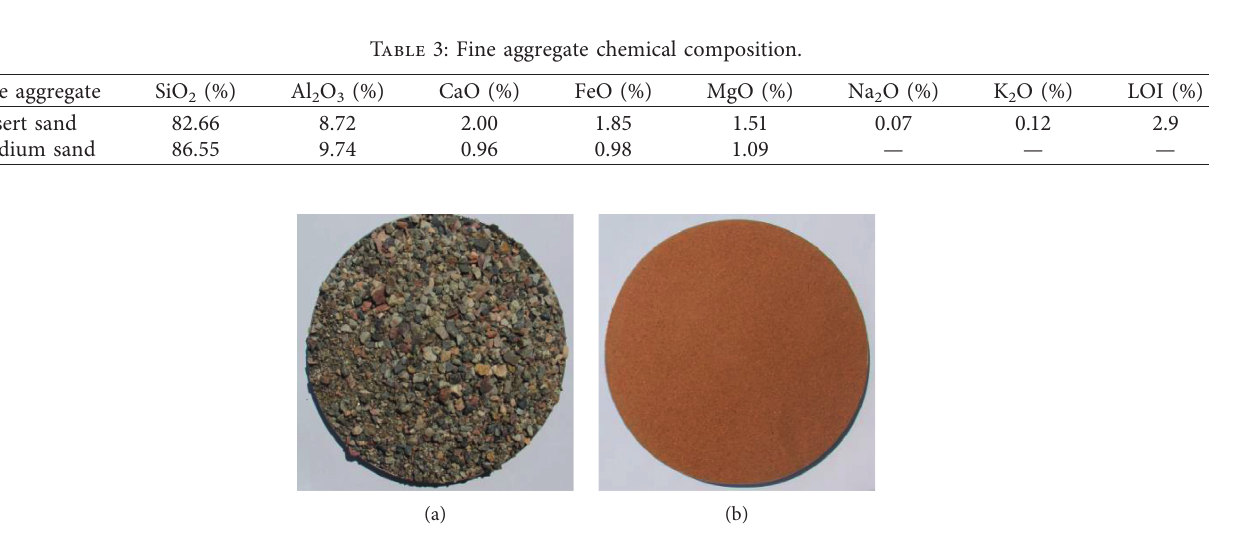
Figure 1: Appearance comparison between medium sand and desert sand. (a) Medium sand. (b) Desert Table 4: Physical properties of aggregates.